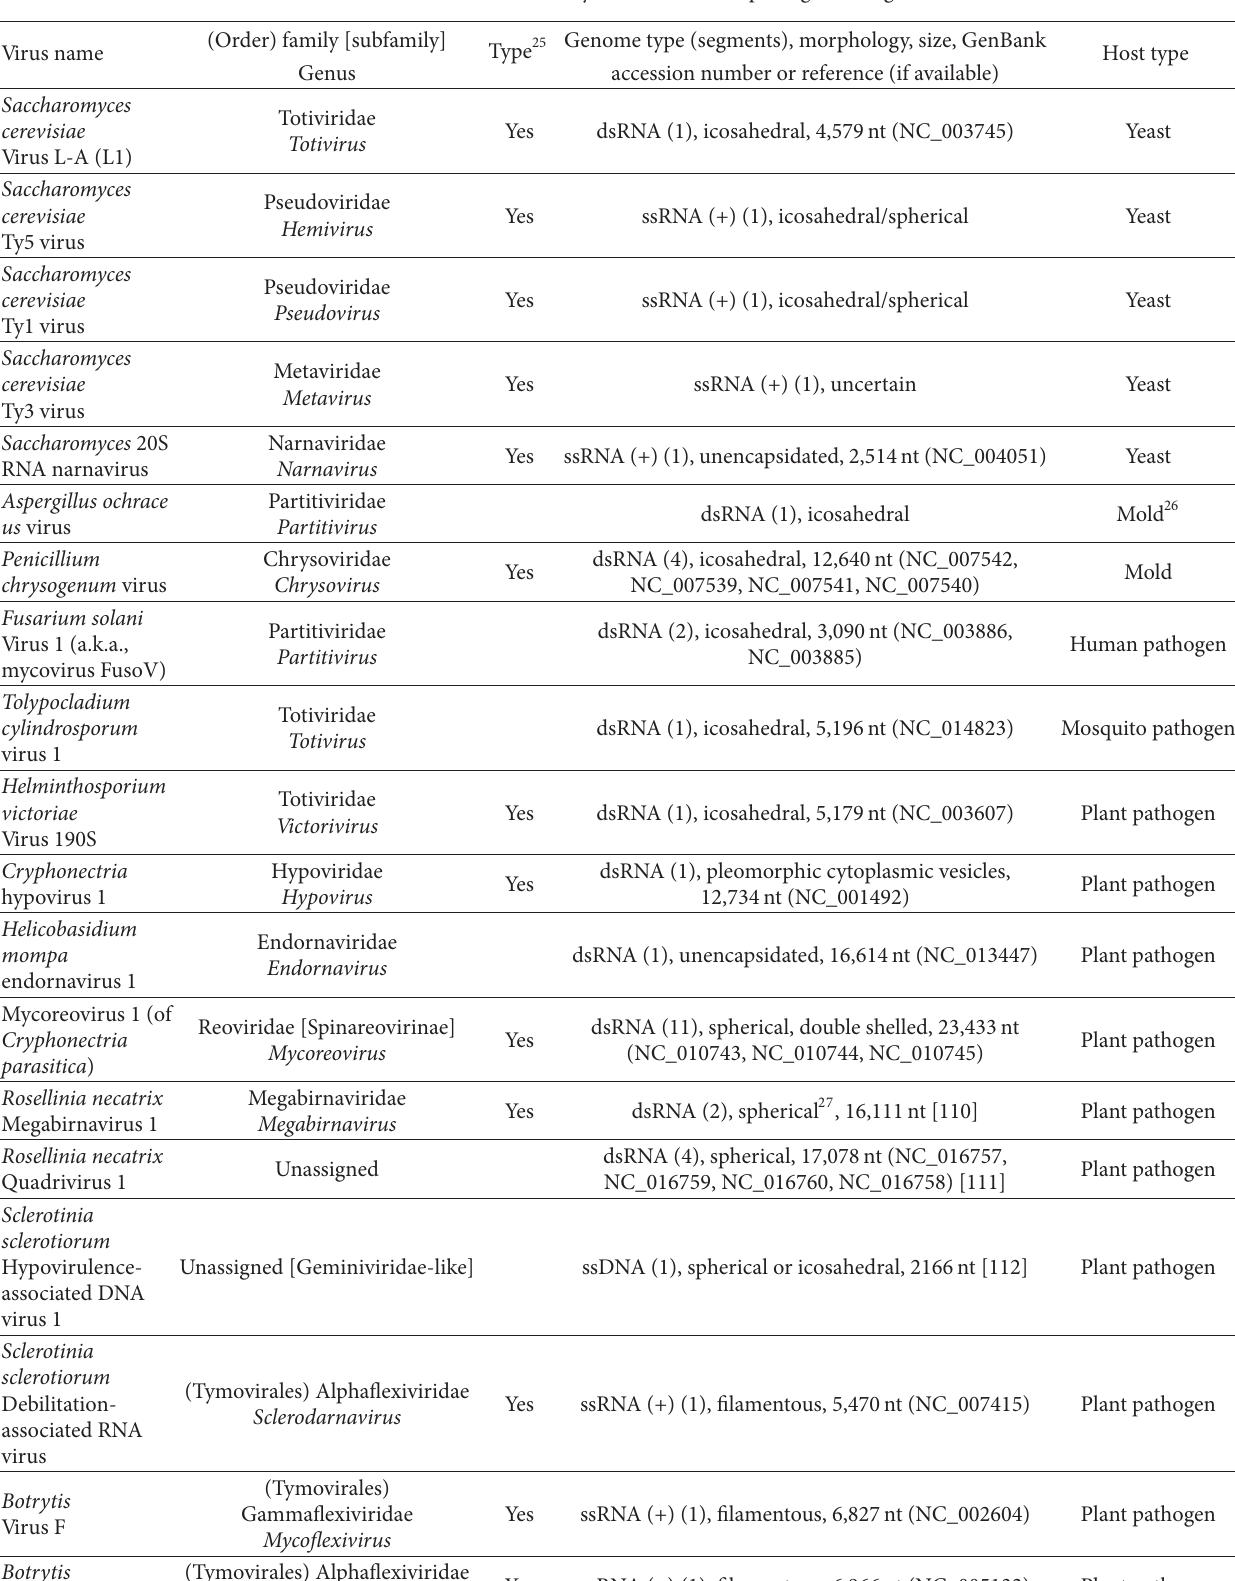
T 4: Notable viruses of yeasts, molds, and pathogenic